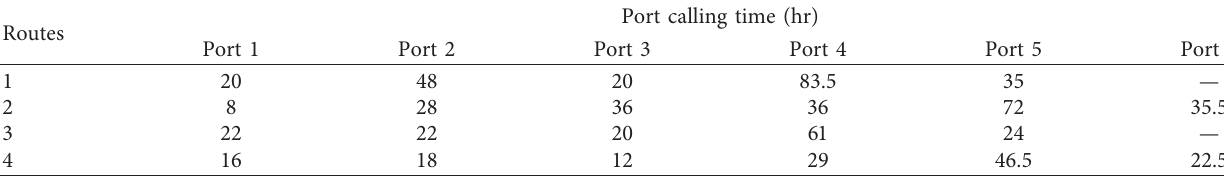
Table 2: Port calling time of each port on each liner route.